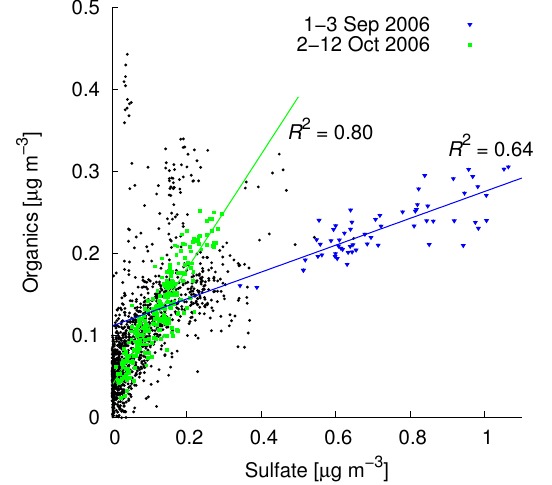
Fig. 5. Scatter plot of nitrate and sulfate concentrations showing data between 5 August 2006 and 12 October 2006. The overall cor- relation is weak with R 2 of 0.24. One group with high correlation is indicated with green points. The remaining data are shown as black points.